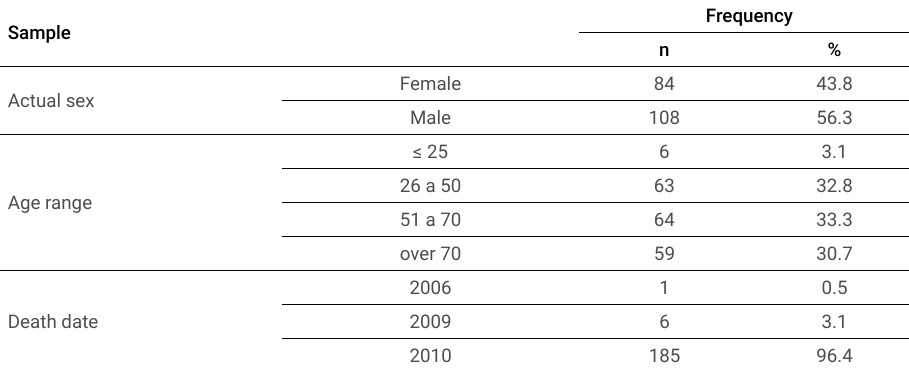
Table 2. Frequency and percentage of actual sex classification, range age and death’s date of the skulls.